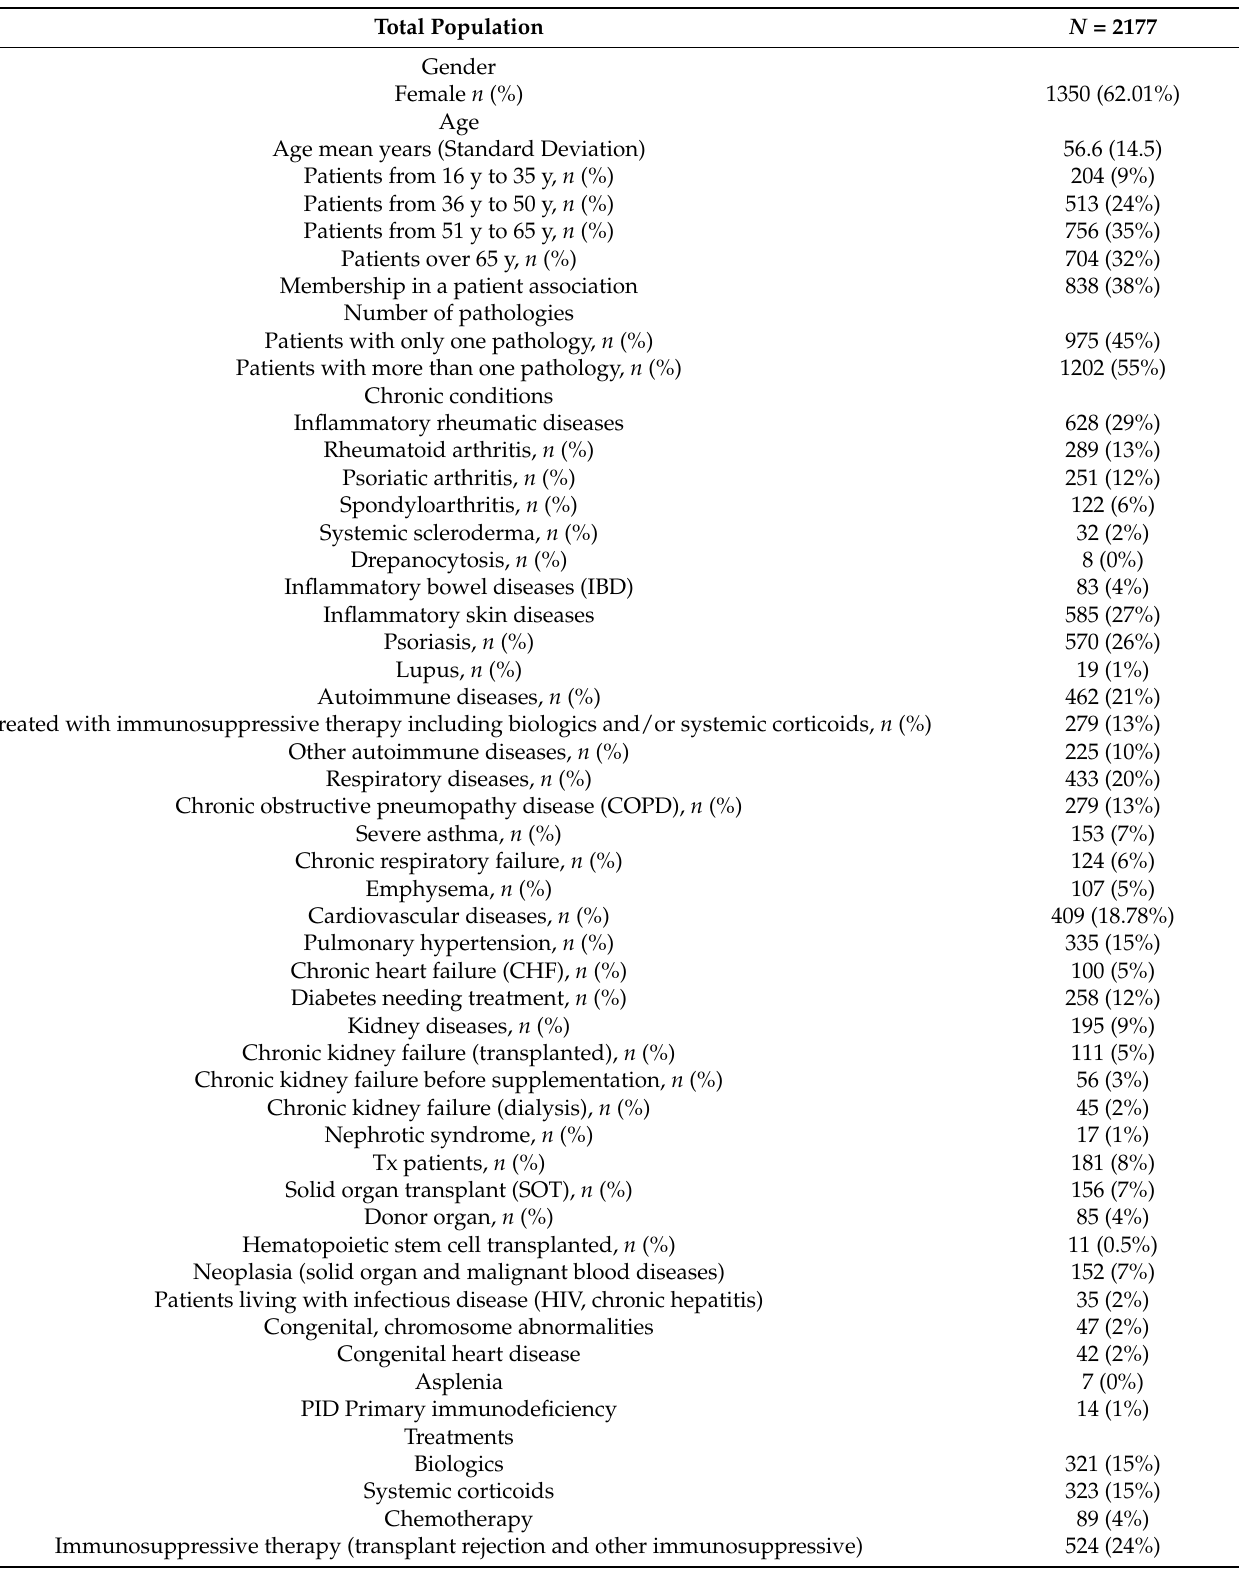
Table 1. Patient